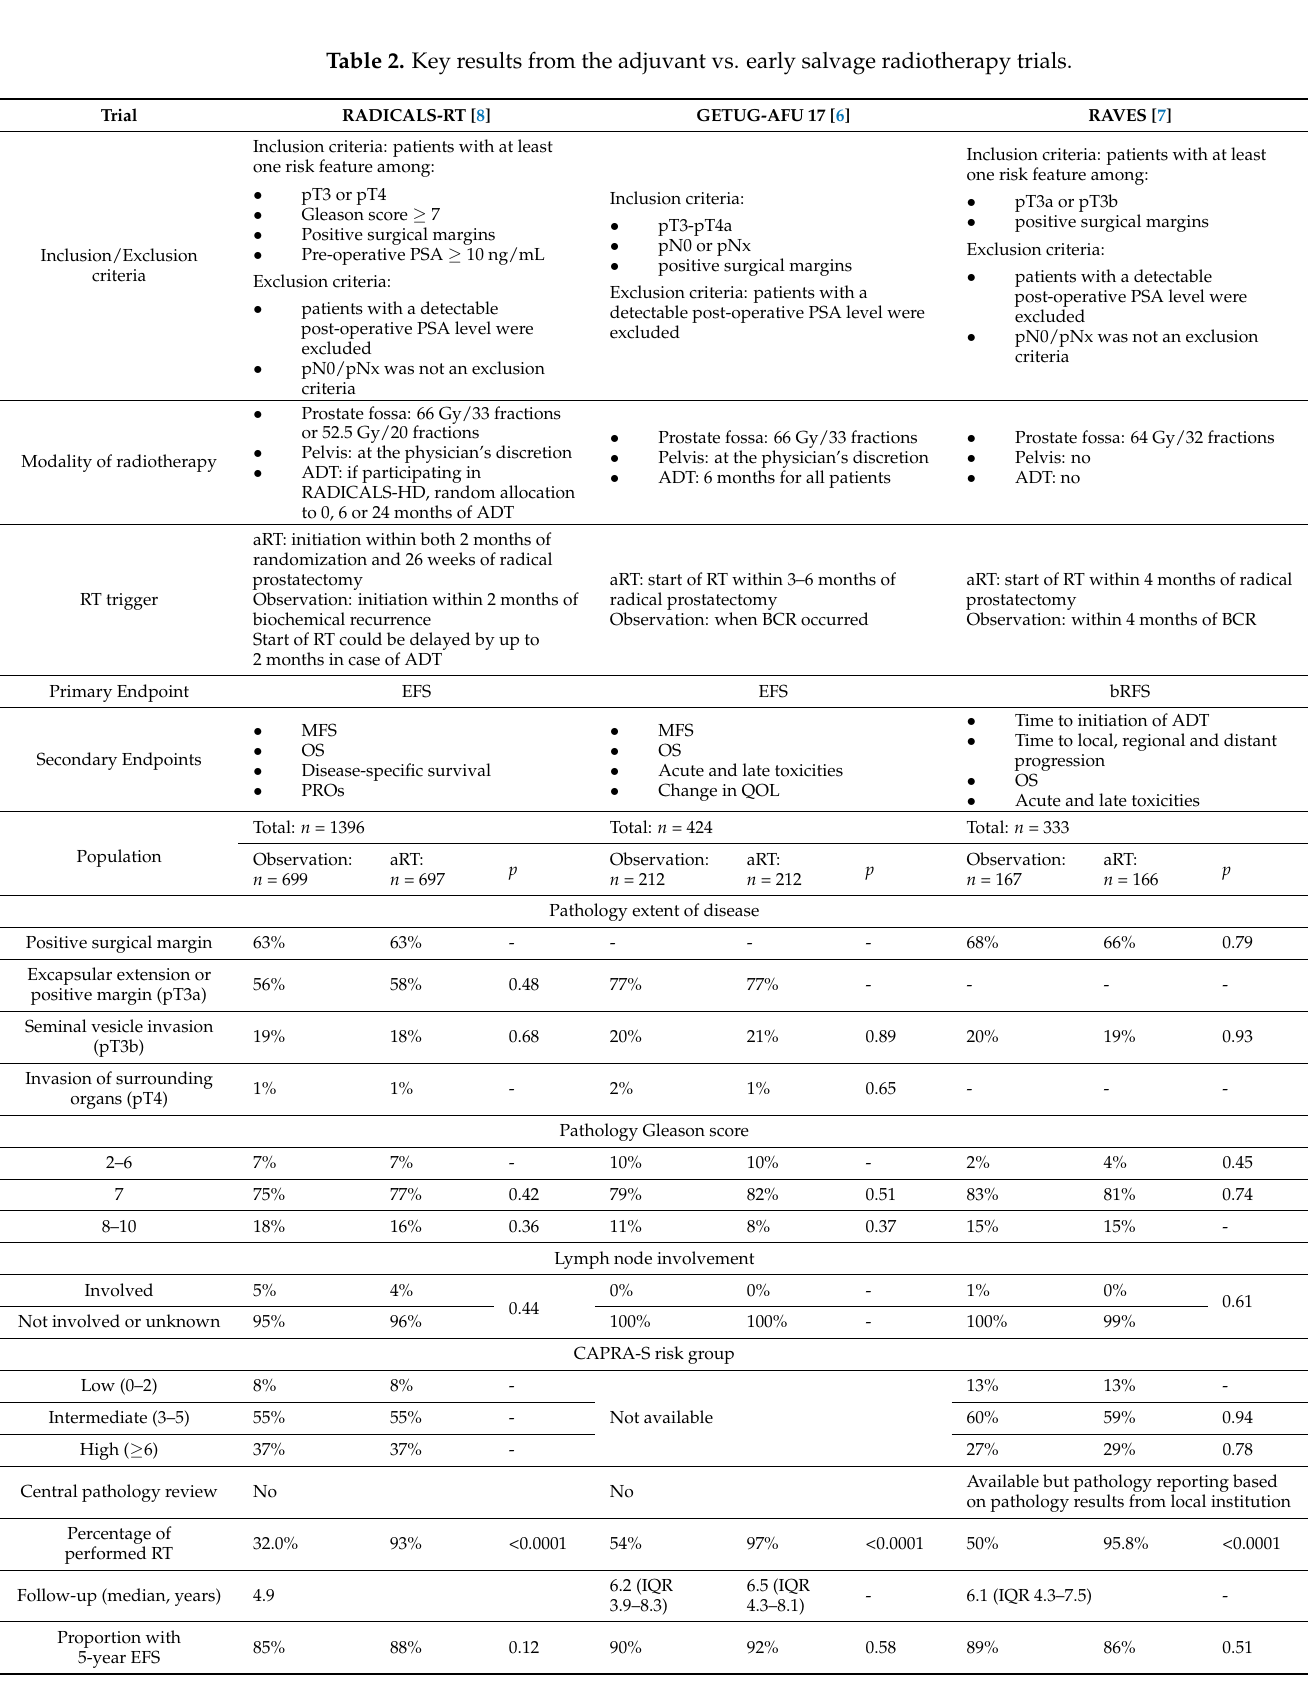
Table 2. Key results from the adjuvant vs. early salvage radiotherapy